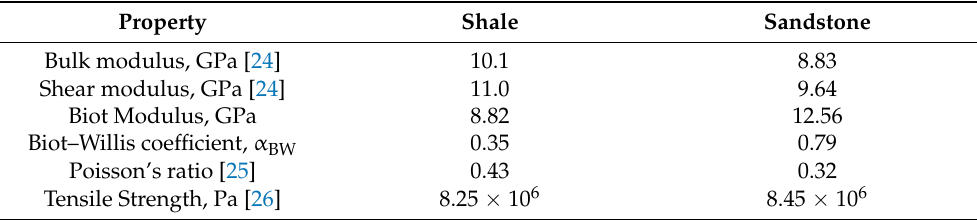
Table 5. The poroelastic property definitions.